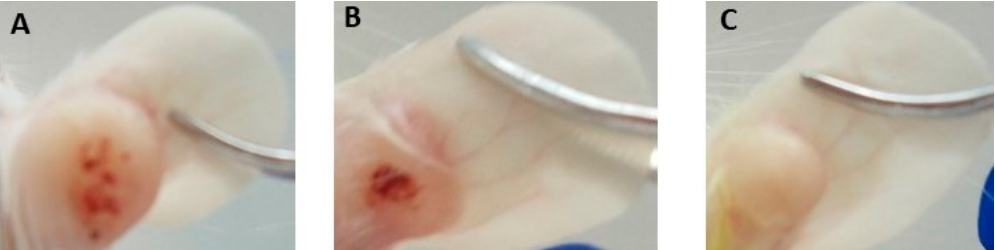
Figure 3. Promastigotes of L. (L.) amazonensis (5 × 10 3 /20 µL) were inoculated in the ear dermis of BALB/c mice. After six weeks postinfection, mice were treated with topical 15% EGCG and Gl. The photomicrographs are showing the efficacy of 15% EGCG and Gl at the end of the experiment (week 10). ( A ) Lesion with elevated border and central crater of an untreated mouse. ( B) Small lesion with thin border of a mouse treated with 15% EGCG . ( C ) Small papular lesion after treatment with Gl.